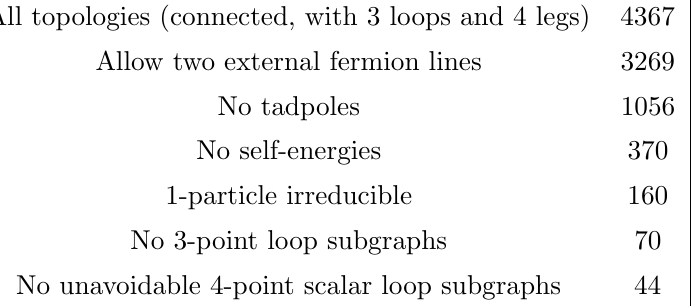
Table 1 . Number of topologies, after the cumulative application of a series of cuts described in the text. Out of the initial 4367, only 44 have all the properties listed above: these are the normal genuine topologies . We would like to point out that dropping the requirement that a topology does no become disconnected by the cut of a single internal line (1-particle irreducibility), the (cid:12)nal number of topologies would still be 44.